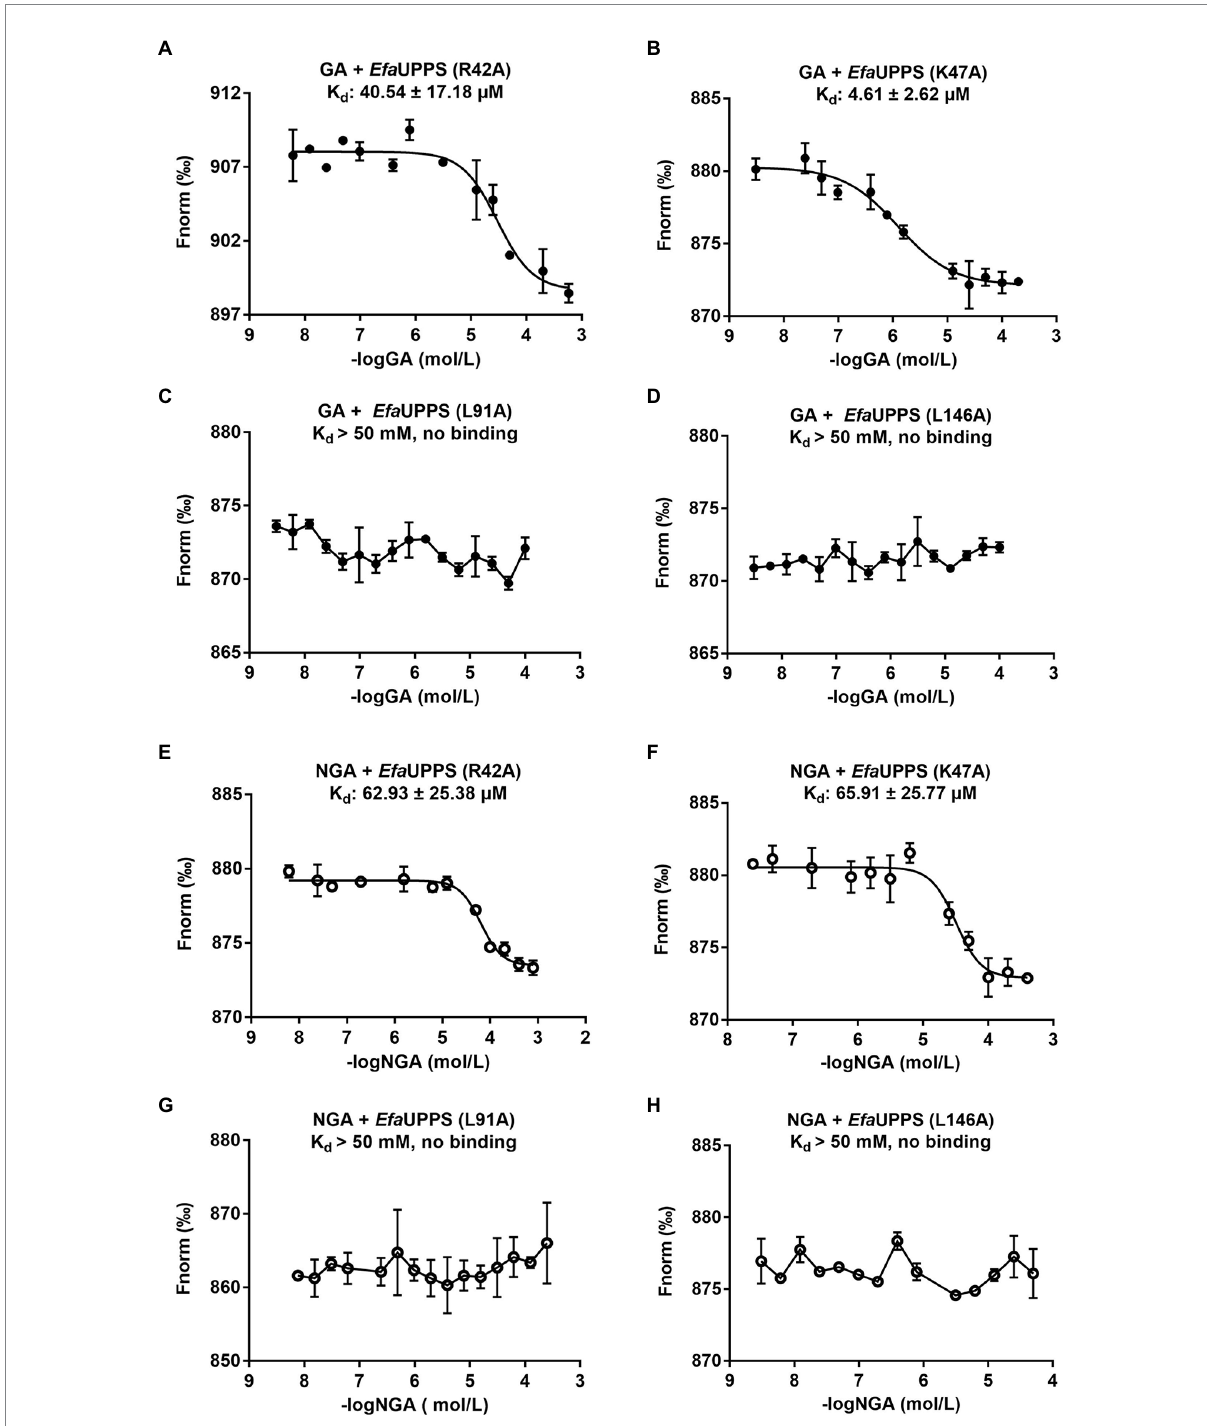
FIGURE 6 MST analyses of the binding of GA/NGA to wild-type and mutated Efa UPPS proteins ( A–H ). The concentration of wild-type Efa UPPS and its indicated mutants is kept constantly at 5 nM, while the GA/NGA concentration ranged from 3.05 nM to 200 μ M. The results of GA were plotted with solid dots, while the results of NGA were plotted with hollow dots. The data are presented as means of three independent biological replicates. Error bars represent mean ± SEM of n = 3